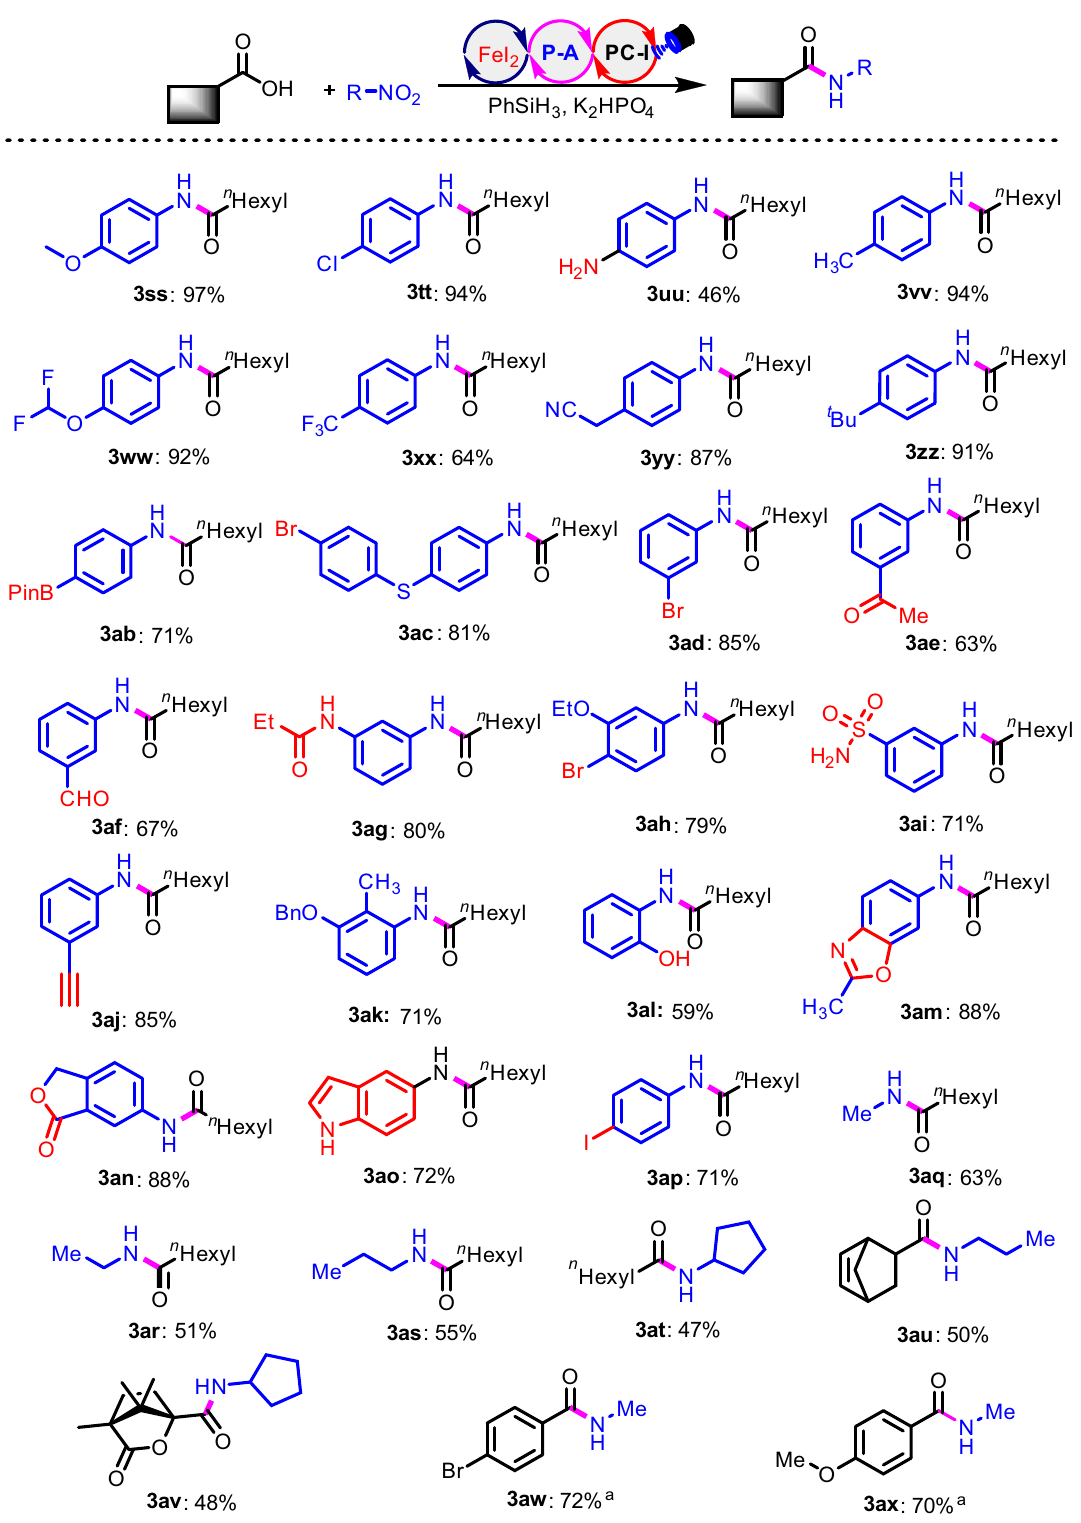
Fig. 3 The scope of the organonitro compounds. Standard conditions: 1a (0.2 mmol), R-NO 2 2 (0.24 mmol), PC-I (1 mol%), P-A (30 mol%), FeI 2 (15 mol %), K 2 HPO 4 (0.5 equiv), PhSiH 3 (1 mmol), MeCN (4 ml), blue LEDs, ambient temperature, 24-36 h. a 2.0 equivalent nitromethane was